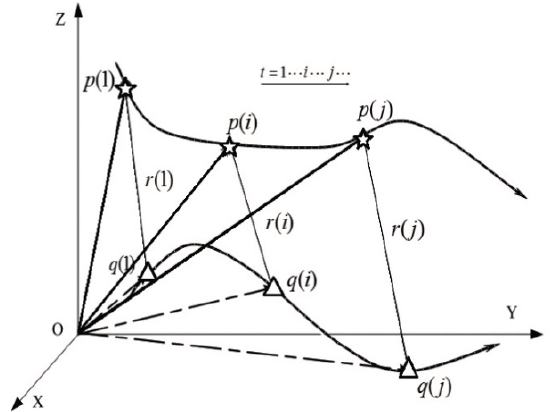
Figure 1. Point reconstruction